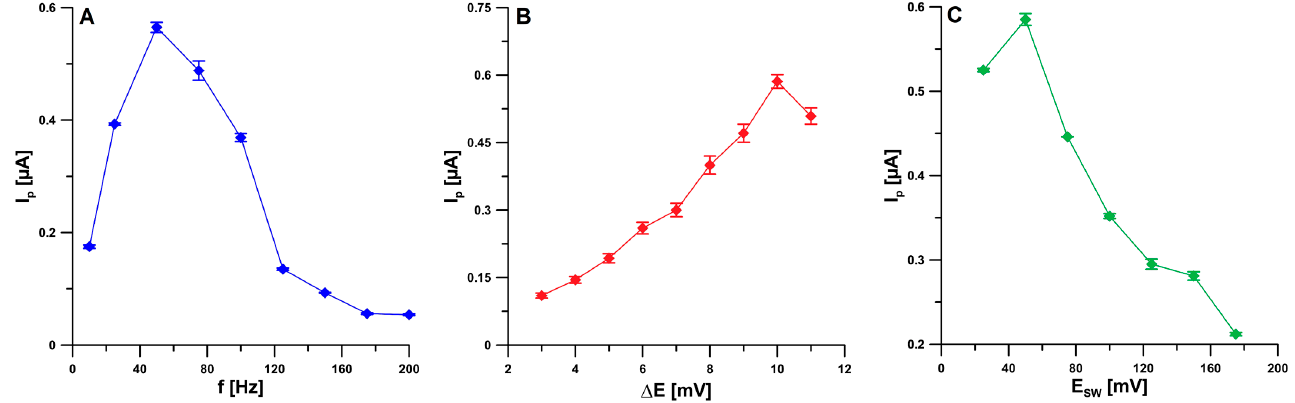
Figure 7. The dependence of f ( A ), Δ E ( B ), and E SW ( C ) on the 2 nM BLM peak current. The received average values of the peak current are shown with a standard deviation for n = 3.